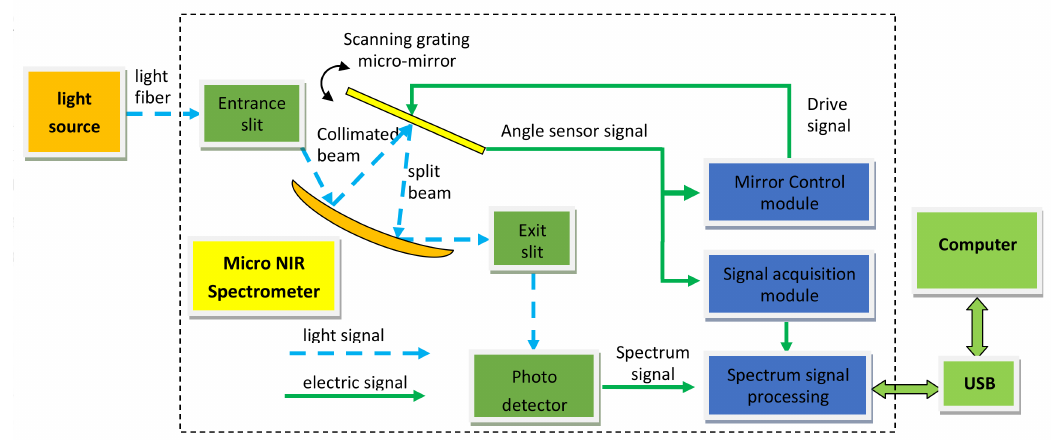
Figure 1. The system structure principle of a micro-NIR